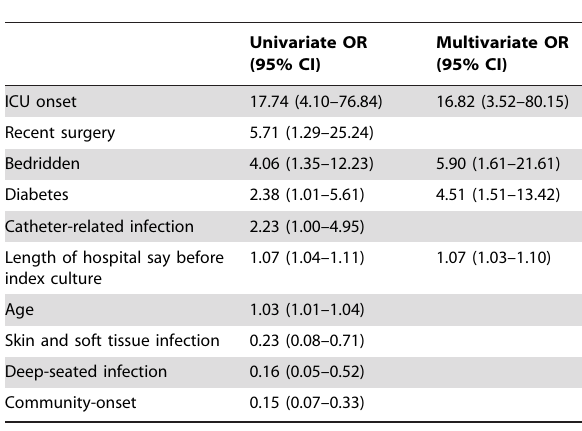
Table 3. Results of univariate and multivariate logistic regression analyses (SCC mec II/III isolates vs. SCCmec IV/V